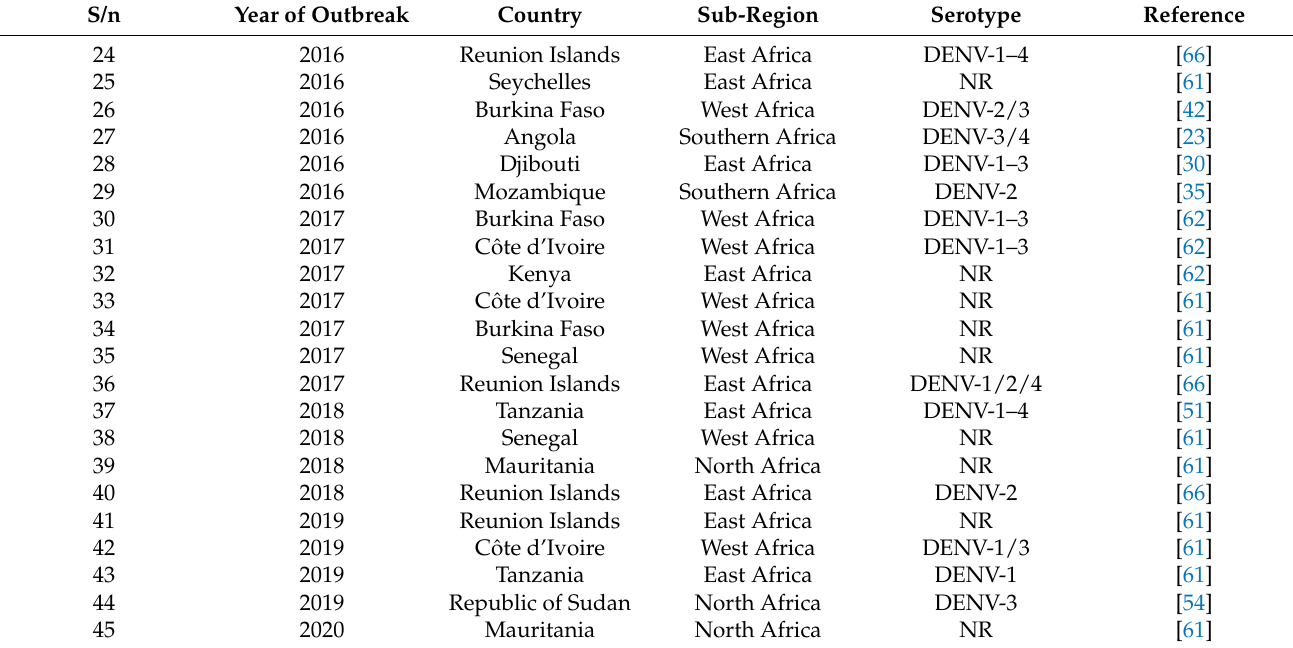
Figure 3. The longitudinal trend of dengue virus serotype proportion in Africa, 1964- 2020. The color codes represent DENV-1 (red), DENV-2 (dark khaki), DENV-3 (green), DENV-4 (blue), and Mixed serotype (pink). The graph was created using R software version 3.5.2 with a primary pack- age ggplot2 at https://cran.r-project.org/bin/windows/base/old/3.5.2/. 3.3. Dengue Prevalence Overall, the prevalence of DENV in Africa was 14% (95% CI, 9−19%), N = 15,807). Substantial heterogeneity was found between studies during outbreak (I 2 = 99%, p < 0.01) and non-outbreak (I 2 = 95%, p < 0.01) periods (Figures 4 and 5). Subgroup meta-analysis showed that the prevalence of DENV was 29% (95% CI, 20−39%, N = 8966) and 3% (95% CI, 1−5%, N = 6841) during outbreak and non-outbreak periods, respectively (Figure 6).